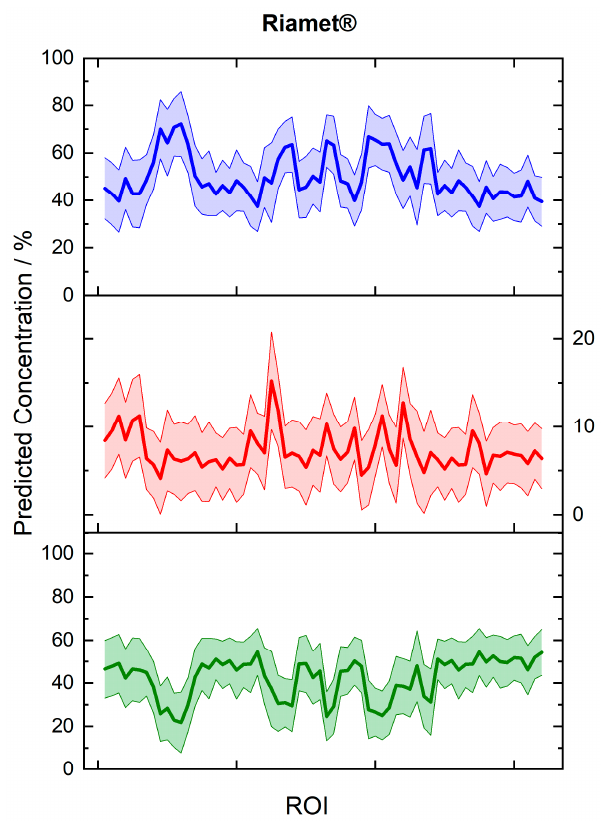
Figure 4. Predicted concentrations for 64 random spots from 30 regions (30 hyperspectral images) of the three constituents in Riamet ® : lumefantrine (green line, lower graph), artemether (red line, middle part), and hypromellose (blue line, upper graph). The respective prediction error ranges are shown. Local differences in the distribution of the concentrations of active ingredients in the tablet are revealed. Each region of interest (ROI) indicates the imaged area from a single fiber in the fiber array.